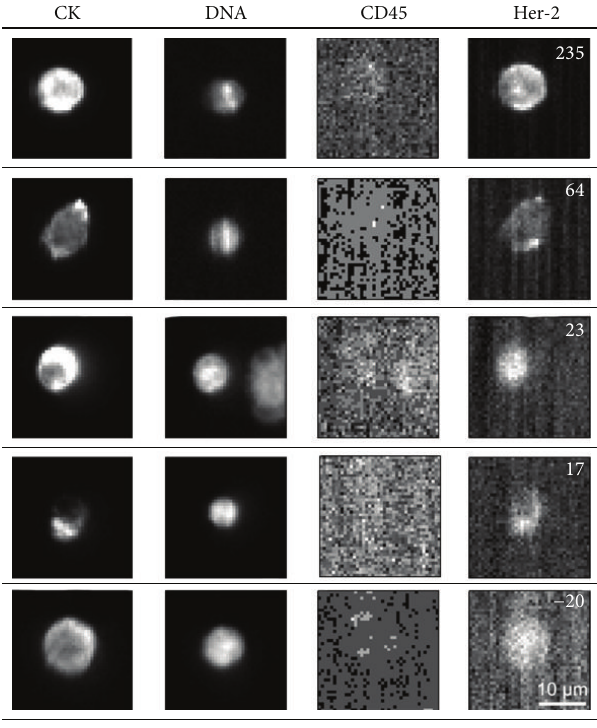
Figure 6: Example of five CTC from five different patients. Flu- orescence of CTC Her-2 expression (right column) is quantified by the number in upper right corner. A higher positive number represents a higher Her-2 expression, whereas a negative number (bottom picture) represents no Her-2 expression on that CTC. The scale bar is applied to all images. Adapted figure from